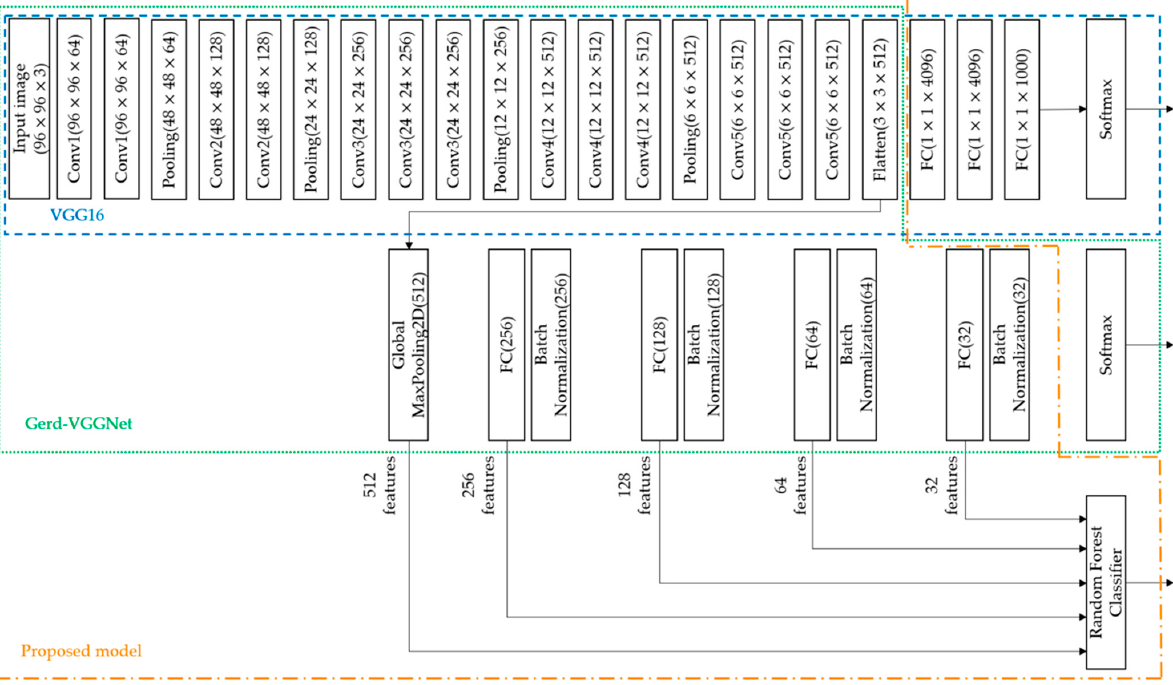
Figure 3. Proposed model